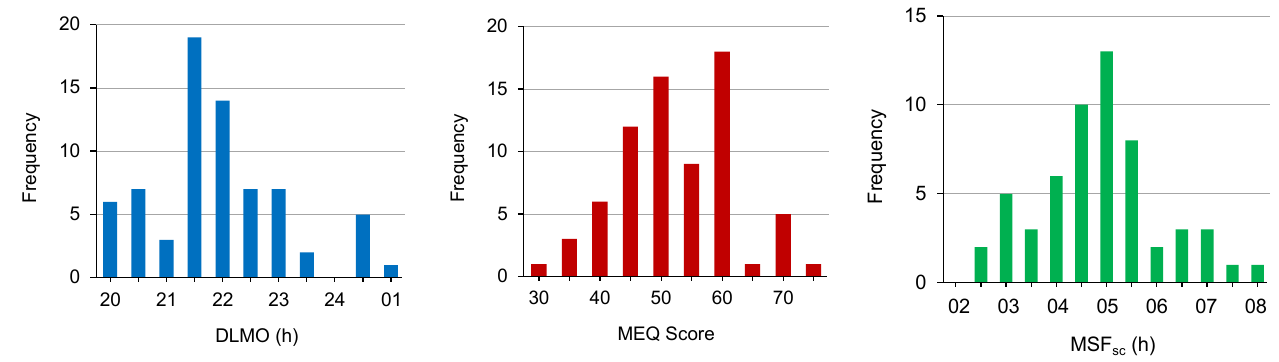
Figure 1. Frequency distributions of DLMO ( n = 71), MEQ score ( n = 72), and MSF sc ( n = 57).